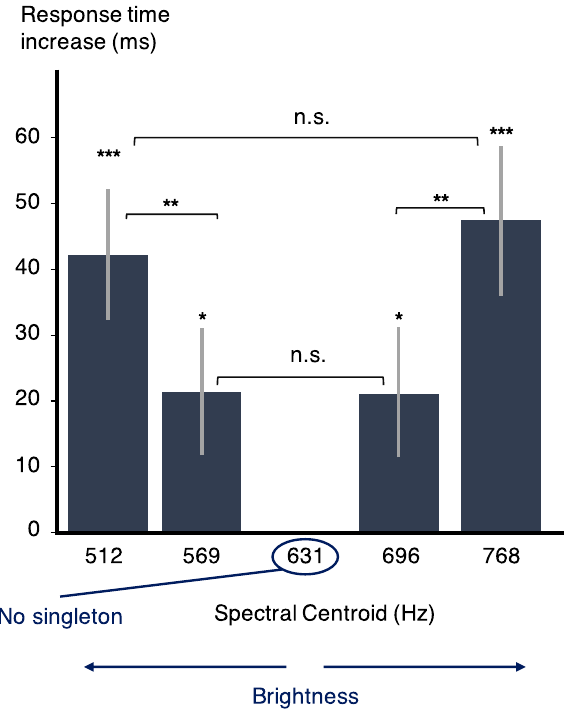
Figure 3. Increase in response time (ms) with singleton SC (experiment 4). Error bars represent the standard errors across participants in each condition compared to the no-singleton condition. Significances between conditions are displayed on the horizontal braces. *: p < .05, **: p < .01, ***: p < .001.